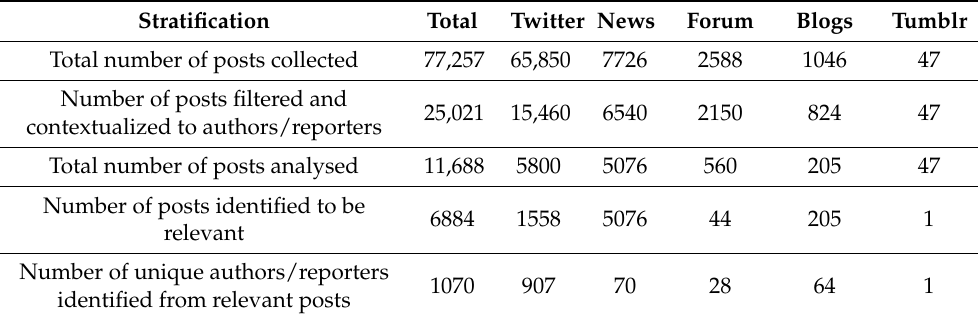
Table 1. Summary of posts analysed.